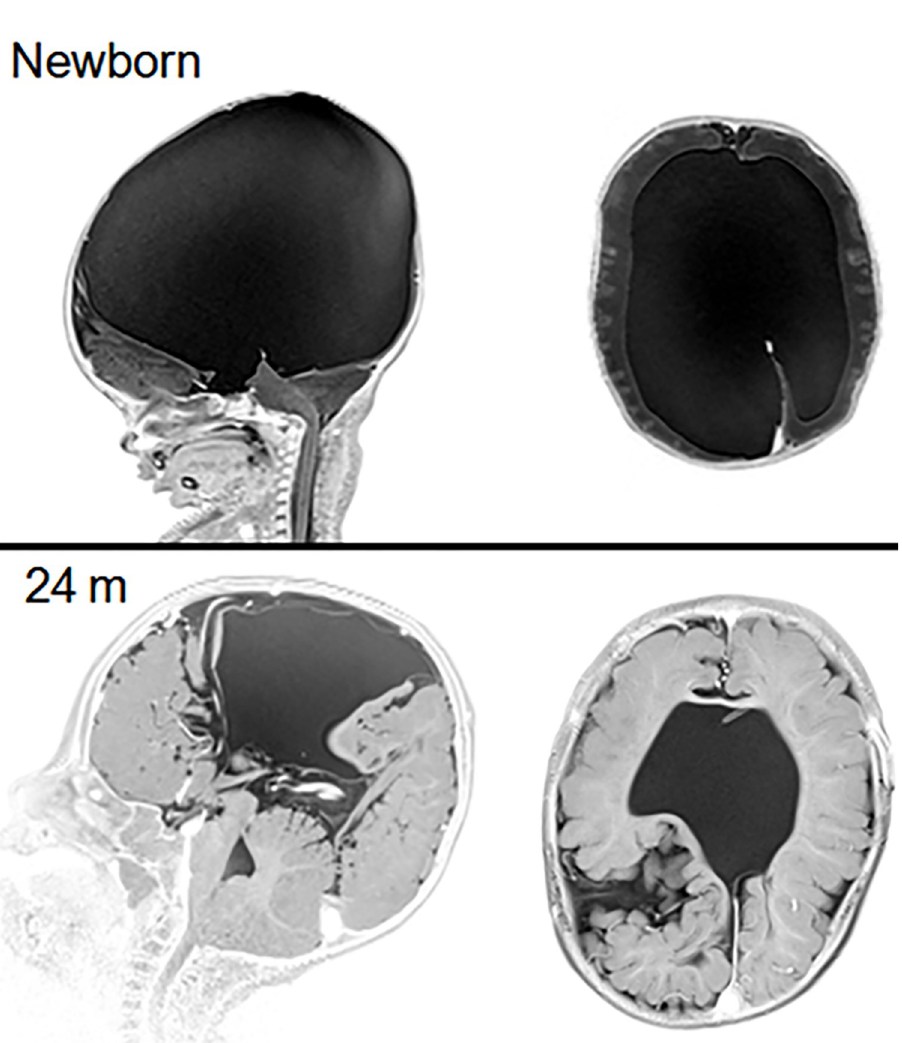
Fig 3. Representative example of boy with hydrocephalus due to aquaeductal stenosis. On the top, T2 sequence magnetic resonance imaging at birth showing the aquaeductal stenosis and the consequent hydrocephalus. On the bottom, T2 sequence magnetic resonance imaging control at 2 years old showing excellent cortical growth and normalization of the HC after VPS implantation. The pressure valve needed to be modified 8 times and the final pressure valve value amounted to 3 cm H 2 O (VPS: ventriculoperitoneal shunt; HC: head circumference).